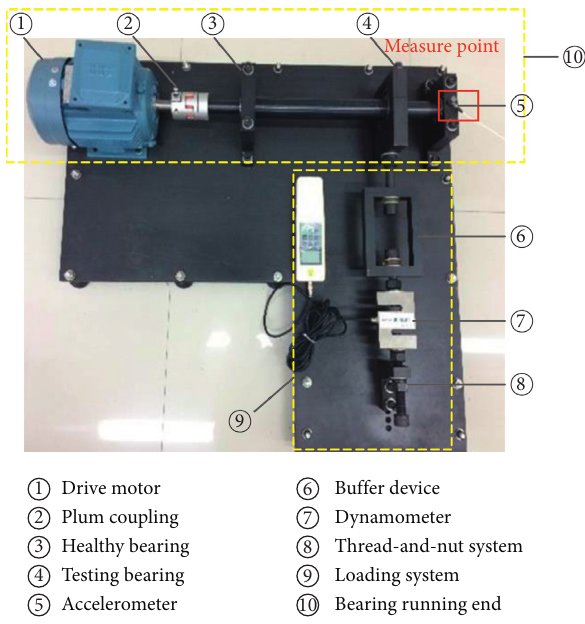
Figure 5: Bearing test platform. Table 2: Description of 14 health conditions with both single and compound